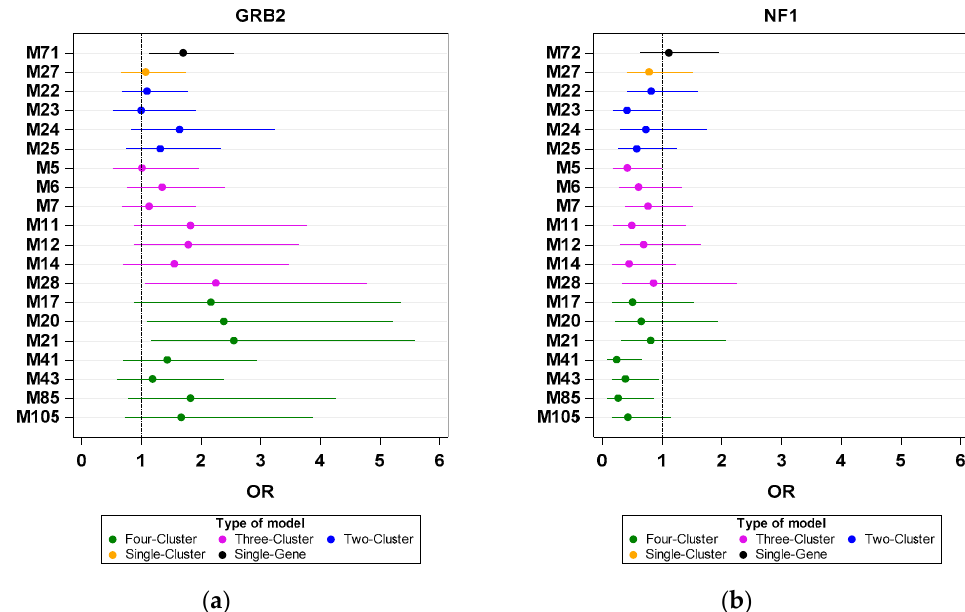
Figure 3. Odds ratios (ORs) of investigated genes based on single-gene, single-cluster, and multiple- cluster analyses. The X- and Y-axes are the OR and Model ID, respectively. ( a ) GRB2 and ( b ) NF1 . Fourth, with respect to two factors ( MCM4 and WEE1 ) in the CY cluster, the findings of the TLA-derived negative effect on their PS were mostly similar to those obtained from the two-cluster analysis. MCM4 /CY and WEE1 /CY lost significance (PS < 50) upon the inclusion of the TLA cluster in the three- and four-cluster models (M14, M16, M17, M85, M87, M88, and M105; Figure 4). However, the addition of the TRf or TRm cluster to the LY/CY/SN set slightly compensated for the SN-derived negative effect on MCM4 /CY (M41 versus M5 and M43 versus M5; Figure 4a).